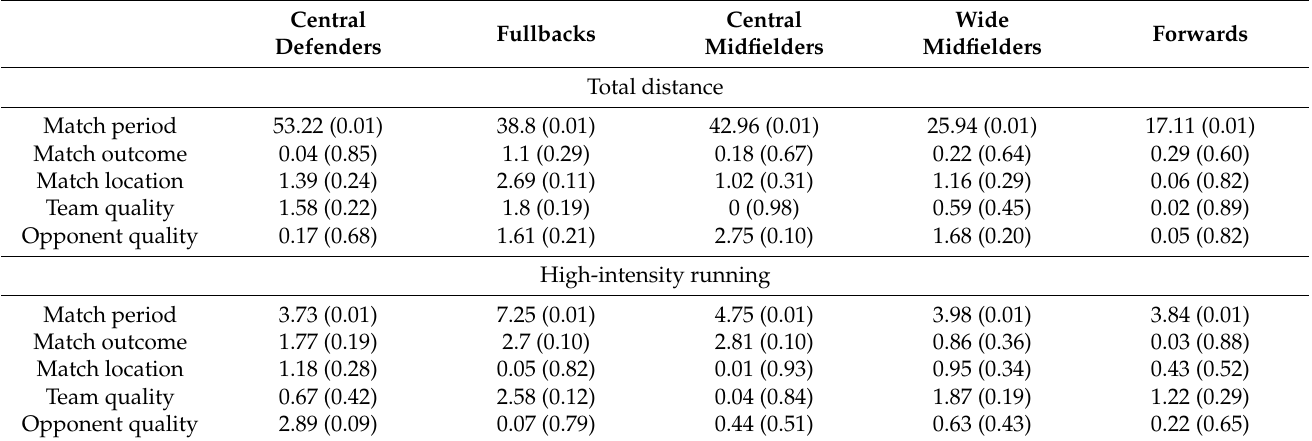
Table 1. Type III tests of fixed effects (data are given as F ( p )).